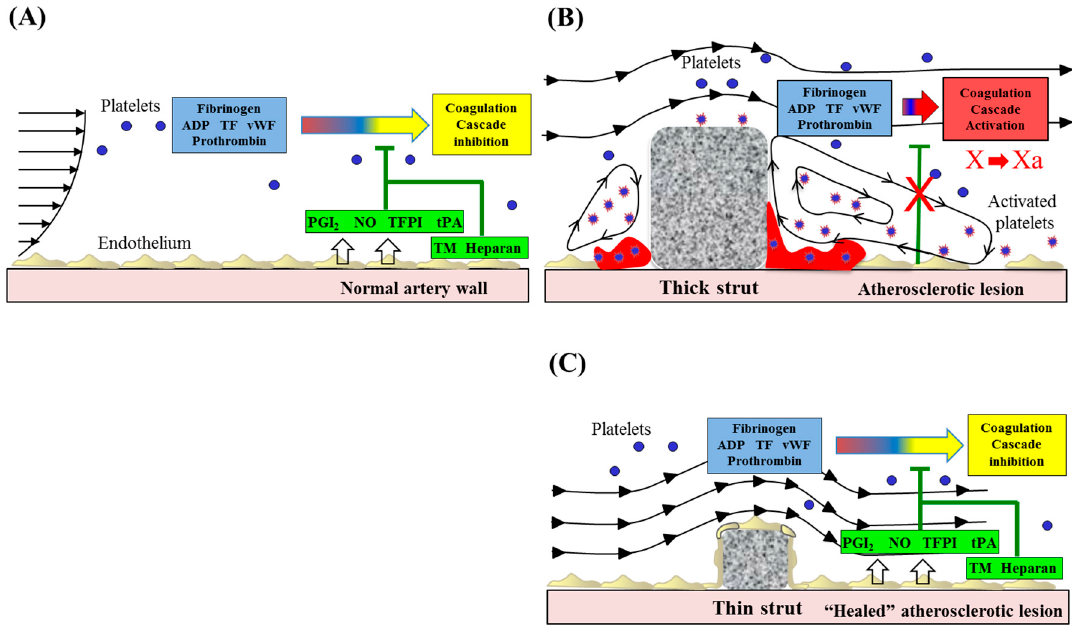
Figure 1. Alteration of blood flow dynamics and thrombogenicity in the vicinity of thin or thick stent struts. Stent-induced flow disturbances affect thrombogenicity and re-endothelialization following stent implantation. ( A ) Healthy endothelium in the normal artery wall expresses anticoagulant and antithrombotic molecules, including NO, PGI2, TFPI, tPA, TM, and heparin-like molecules. ( B ) Stent placement results in local endothelial denudation, which leads to activation of the coagulation cascade. Stents, especially thicker strutted ones, may promote non-streamlined flow separation in regions proximal and distal to struts. Accelerated blood flow (high shear) over the strut edges can activate platelets through the release of thromboxane A2 and ADP, whereas flow recirculation zones with low shear rates are associated with inhibition of re-endothelialization, potentially enabling procoagulant and proinflammatory elements to accumulate, which contribute to thrombus formation. ( C ) A thin strut geometry reduces flow separation and low shear, leading to the inhibition of platelet activation. Moreover, the generation of recirculation zones proximal and distal to thin struts will be minimized, resulting in the reduced thrombogenicity. Undisturbed flow proximal and distal to streamlined struts promotes re-endothelialization, which further helps to maintain hemostatic balance and prevent thrombosis. Modified and reprinted with permission from Jimenez, J.M.; et al. Ann. Biomed. Eng. 2009 [14]. ADP: adenosine diphosphate, AR: aspect ratio, CFD: computed flow dynamics, NO: